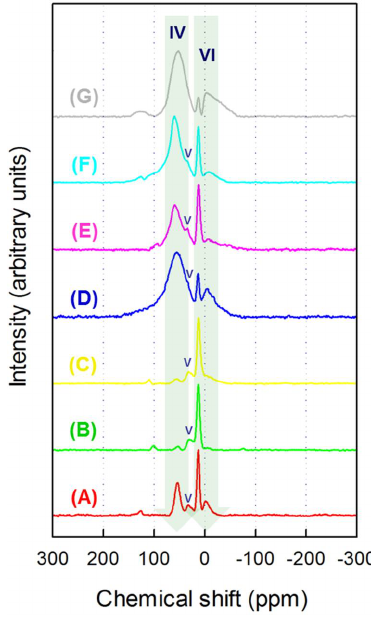
Figure 7. 27 Al MAS-NMR spectra of the silica-alumina nanoparticle precursor after calcination at different temperatures: ( A ) as prepared; ( B ) 500 °C; ( C ) 800 °C; ( D ) 950 °C; ( E ) 1150 °C; ( F ) 1250 °C, and ( G ) 1500 °C.